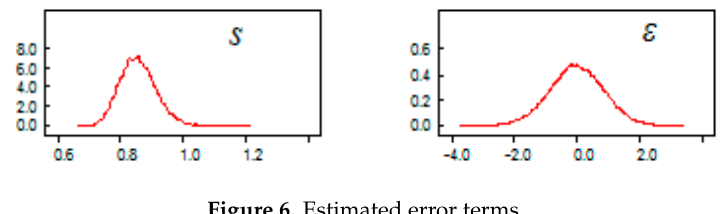
Figure 6. Estimated error terms.